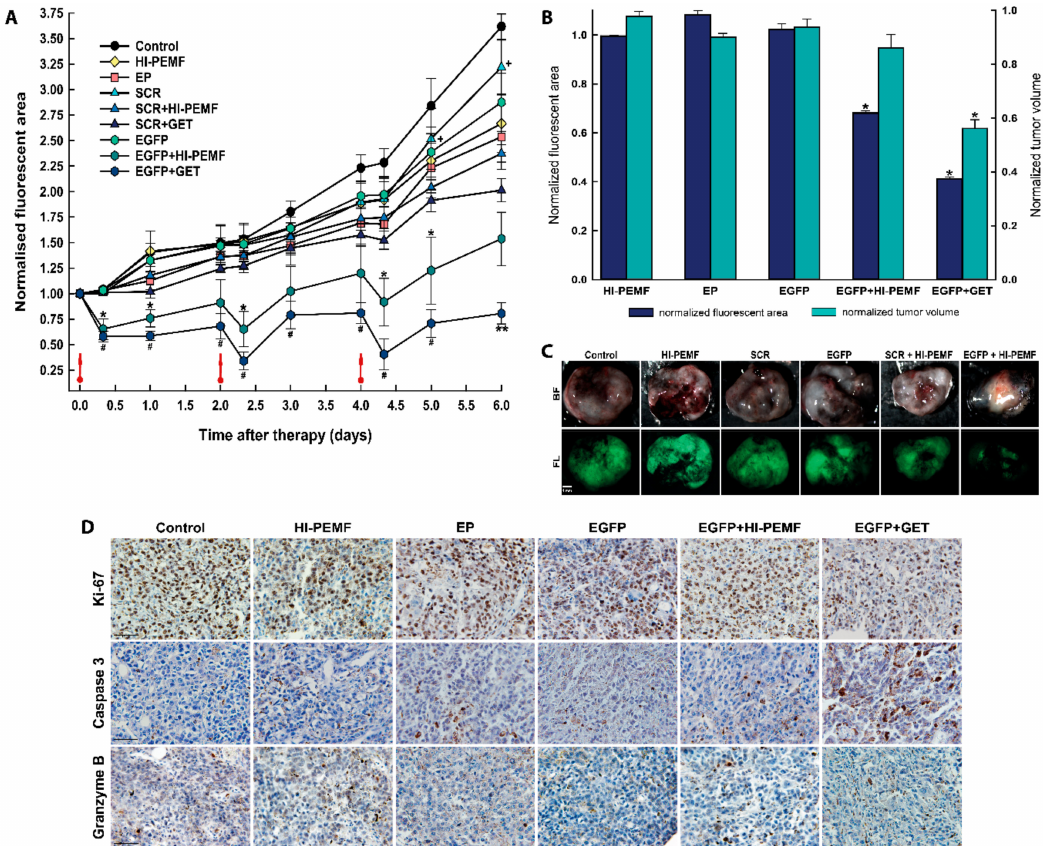
Figure 4. In vivo silencing of enhanced green fluorescent protein (EGFP) with EGFP siRNA using electrotransfer by a high intensity pulsed electromagnetic field (HI-PEMF) or conventional electroporation (EP) in B16F10 tumors stably expressing EGFP. ( A ) Imaging with a fluorescence stereomicroscope was used for the quantification of the time-lapse fluorescence of B16F10 EGFP tumors. For each animal, the fluorescent area of the tumor was measured at di ff erent time points and normalized to the value of the fluorescent area measured just before the first treatment on day 0. B16F10 EGFP tumors were treated with an intratumoral injection of either siMAX universal bu ff er (Control group, n = 6), EGFP siRNA (EGFP group, n = 10), SCR siRNA alone (SCR group-scramble, noncoding siRNA, n = 8), HI-PEMF ( n = 8), or EP ( n = 6), as well as in combination with electrotransfer after electroporation by HI-PEMF ( n = 12) or by conventional EP (EGFP + GET, n = 8; SCR-GET, n = 7). The data represent the mean and standard error of the mean. Red arrows indicate the day on which gene electrotransfer was performed. * p -value < 0.05, significantly di ff erent from all other groups except EGFP + GET group; ** p -value < 0.05, significantly di ff erent from all other groups; # p -value < 0.05, significantly di ff erent from all other groups except EGFP + HI-PEMF group; + p -value < 0.05, significantly di ff erent from SCR + HI-PEMF group and SRC + GET group. ( B ) For each excised tumor, the fluorescent area was measured on day 6, i.e., two days after the last intratumoral injection of either siMAX universal bu ff er or siRNA EGFP or siRNA SCR alone or in combination with the gene electrotransfer mediated by HI-PEMF. For the normalization of the fluorescent tumor area and tumor volume, groups were normalized as follows: HI-PEMF or EP treated tumors were normalized to the control; siRNA EGFP treated tumors were normalized to the group siRNA SCR treated tumors; tumors treated with HI-PEMF and siRNA EGFP were normalized to the group HI-PEMF and siRNA SCR treated tumors; tumors treated with EP and siRNA EGFP were normalized to the group EP and siRNA SCR treated tumors. The data represent the mean and standard error of the mean. Each group consisted of 6 to 12